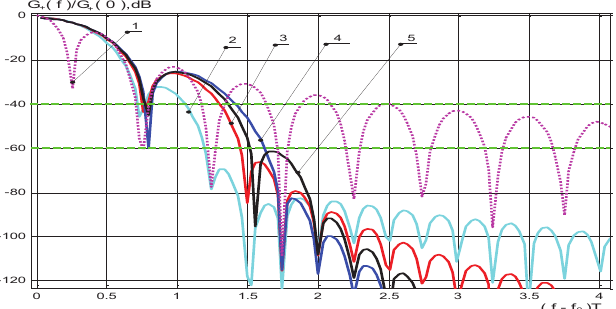
Figure 5. Normalized power spectra curves of the optimized signals. Curve 1 corresponds to the MSK and curves 2–5 correspond to [ n = 1, m = 4 ] , [ n = 3, m = 5 ] , [ n = 5, m = 6 ] , and [ n = 7, m = 7 ] , respectively.